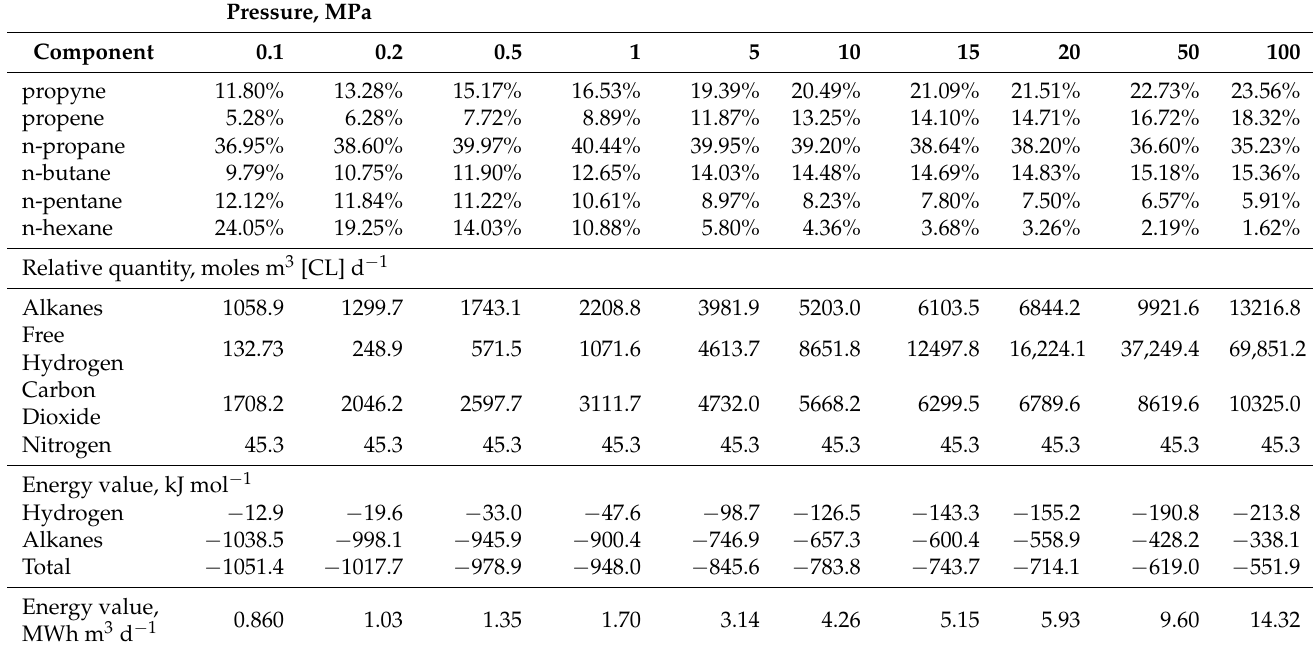
Table 21. Relative molar abundances of the principal product gas components as a function of reactor pressure. T = 348 K.